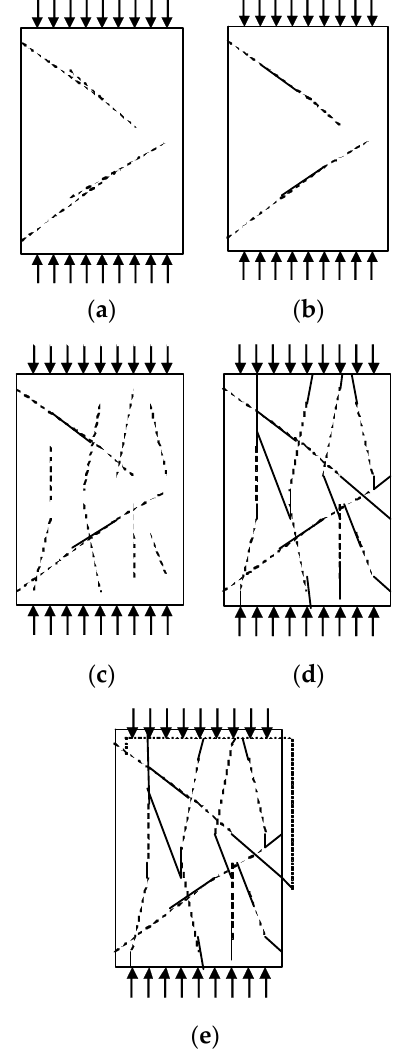
Figure 14. The deformation and failure process of coal and rock materials. ( a ) Original state; ( b ) closure stage; ( c ) new fracture formation and expansion stage; ( d ) fracture confluence and connection stage and ( e ) failure stage.